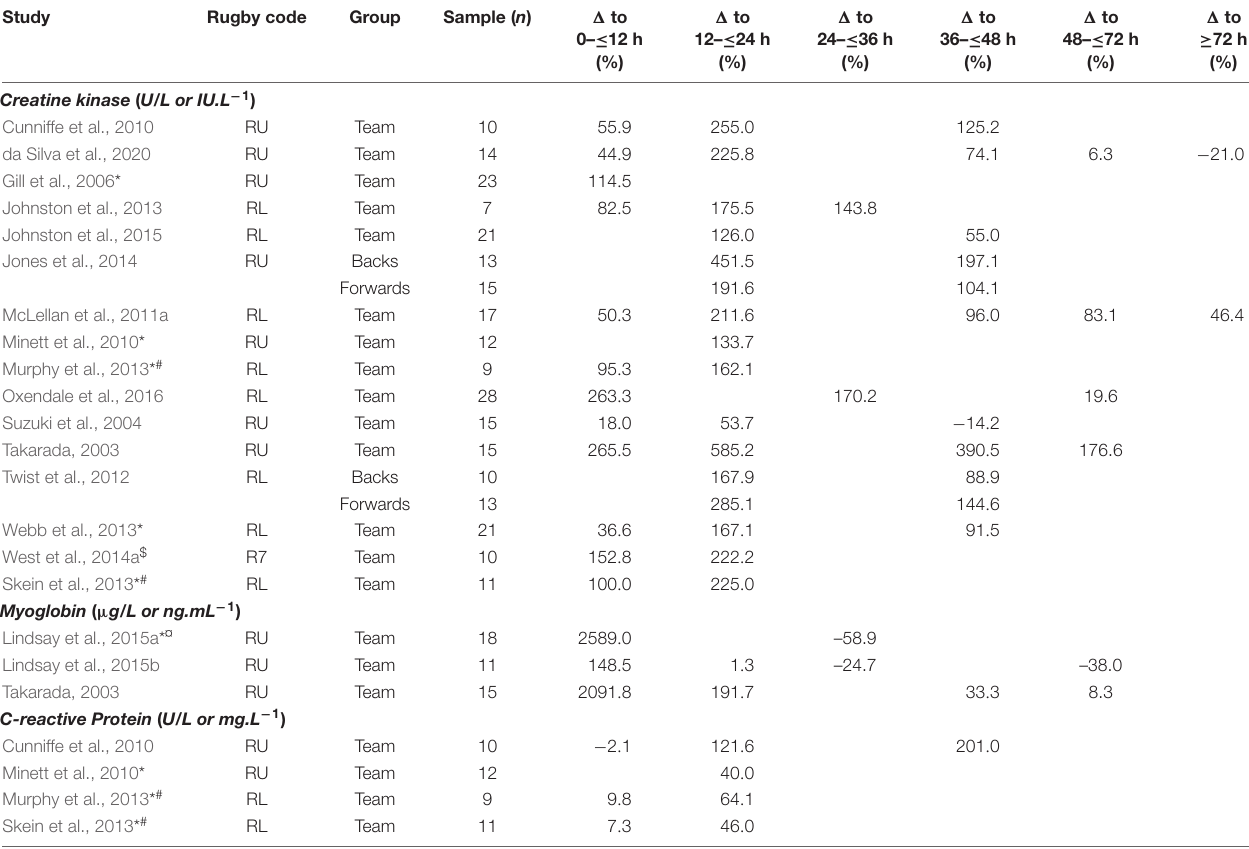
TABLE 2 | Blood biomarkers of muscle damage and inflammation and their change across post-match recovery. Study Rugby